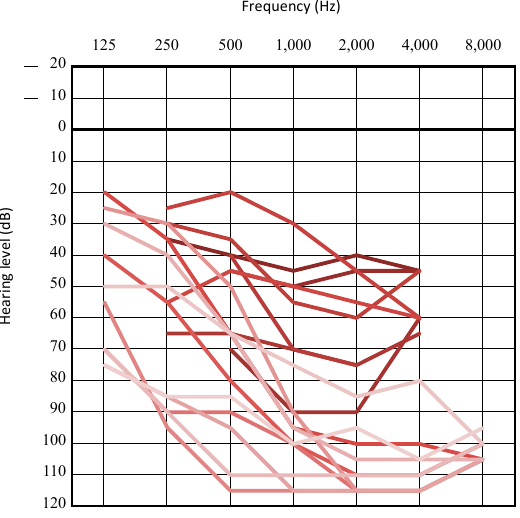
Figure 3. Overlapping audiograms of individuals with c.4212 + 1G > A variation. Pure-tone audiograms or conditioned orientation response audiograms were utilized. Darker colors indicate the hearing thresholds in younger ages, and lighter colors indicate those in older ages. Their ages ranged from 0 to 69 years old.